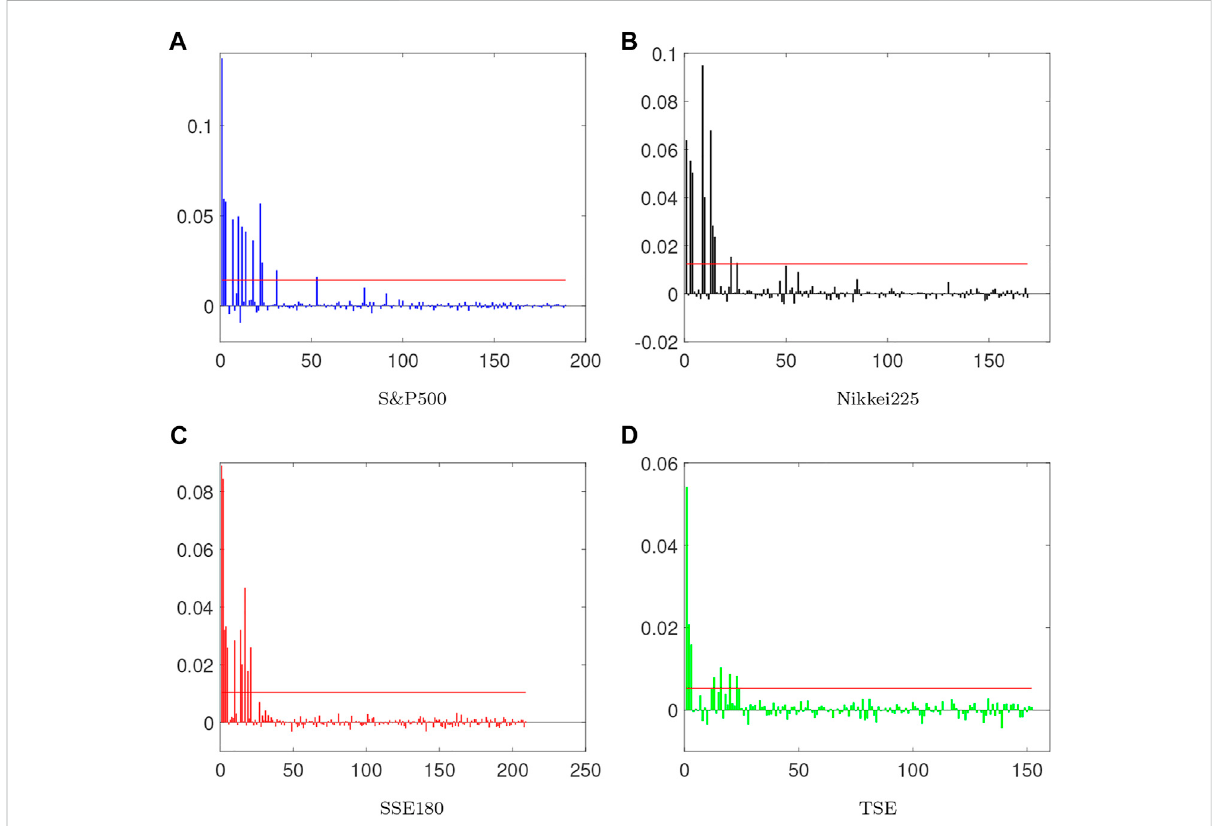
FIGURE 7 Theplots showtherange ofmeanchangesfortheglobalperturbedcorrelationmatrices.Comparingthese graphsusingthestandarddeviation shows that moving toward stationary conditions in mature markets is slower than in emerging ones. (A) S&P500, (B) Nikkei225, (C) SSE180, (D)